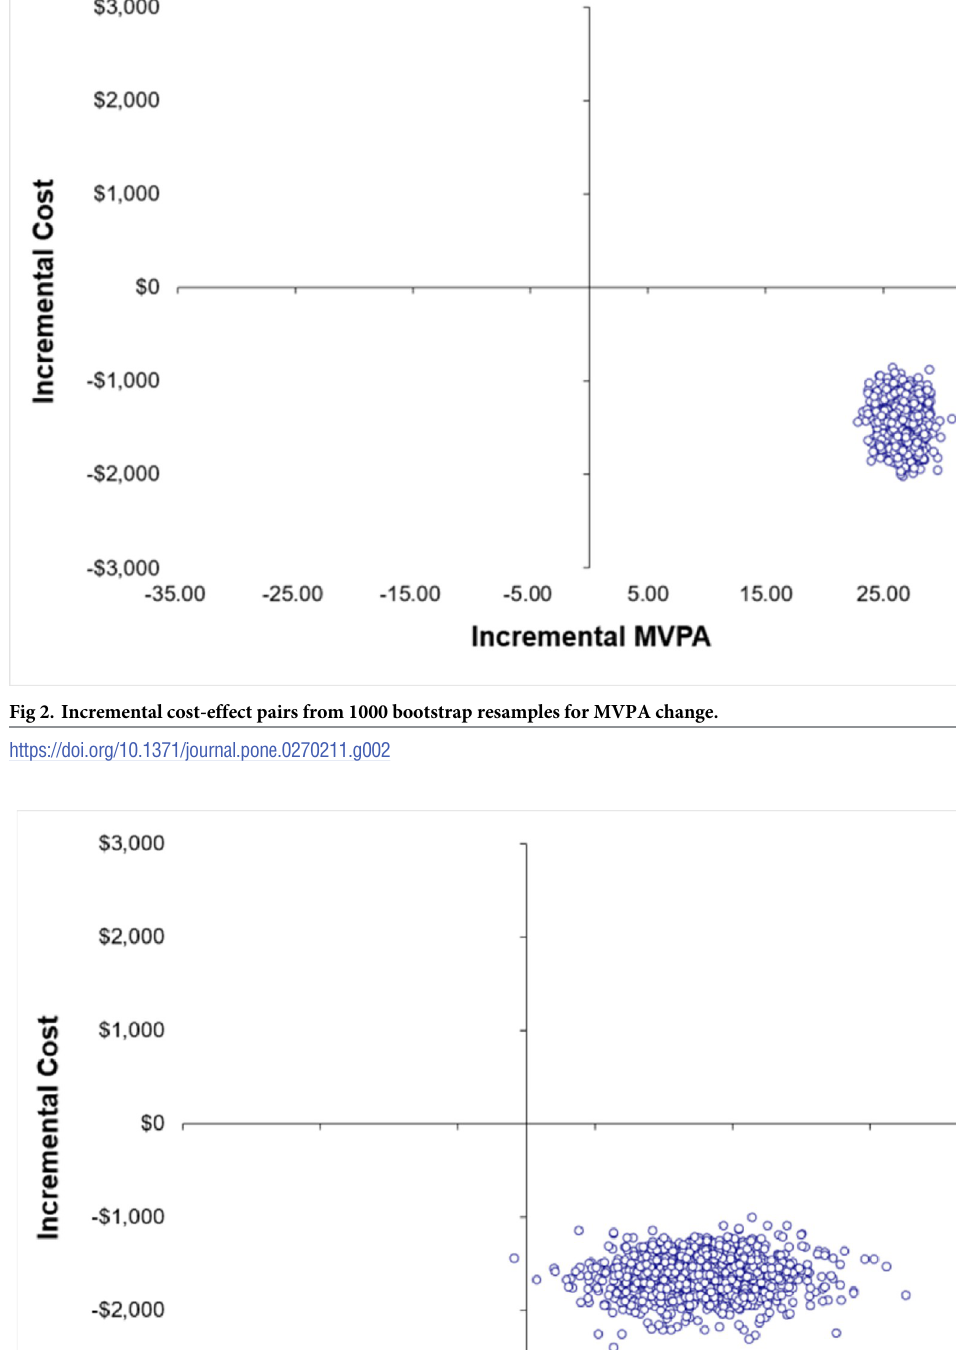
PLOS ONE | https://doi.org/10.1371/journal.pone.0270211 June 23,